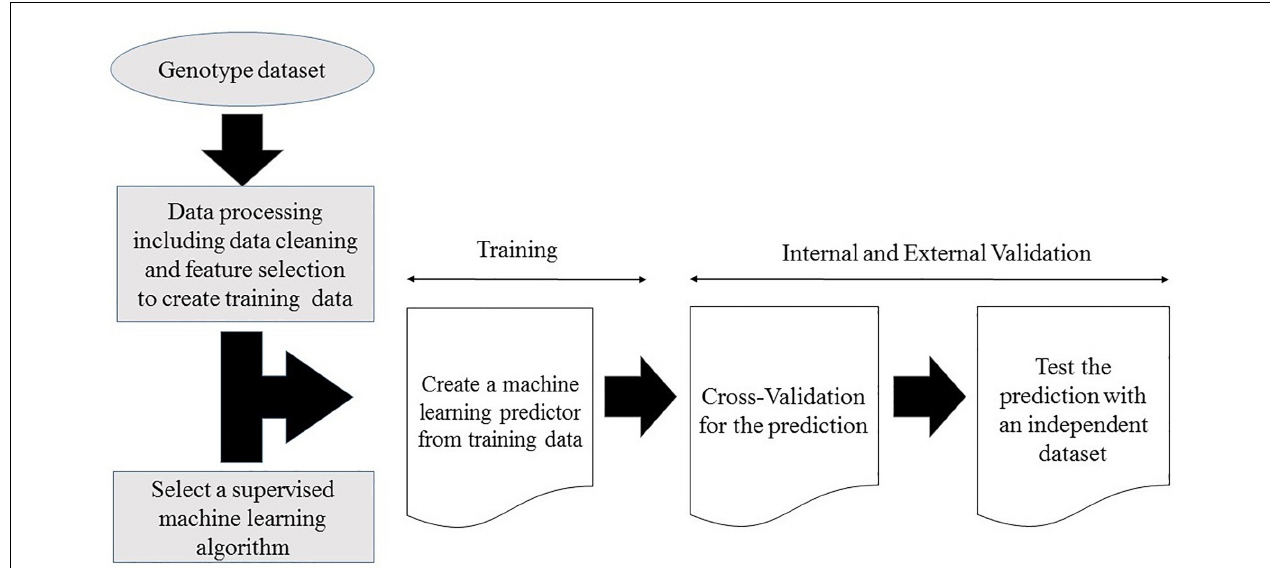
FIGURE 1 | Workflow for creating a supervised machine learning model from a genotype